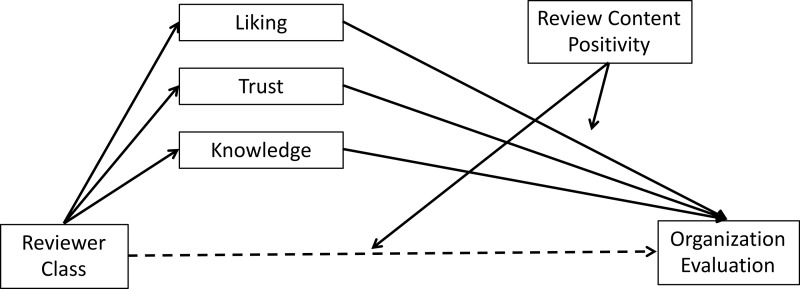
Schematic representation of the bootstrapping mediation analysis from Study 3, with Organization Status included as a covariate.